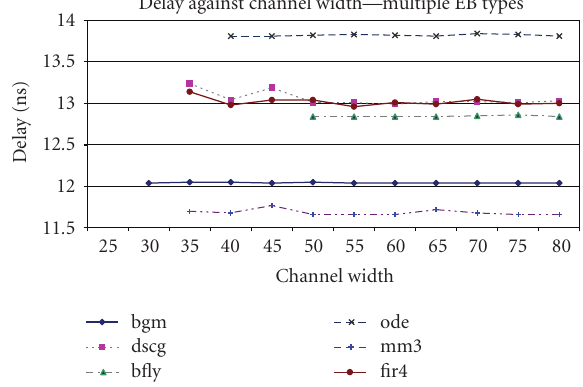
Figure 10: Delay against various EBs’ shape for single EB-type FPGA.